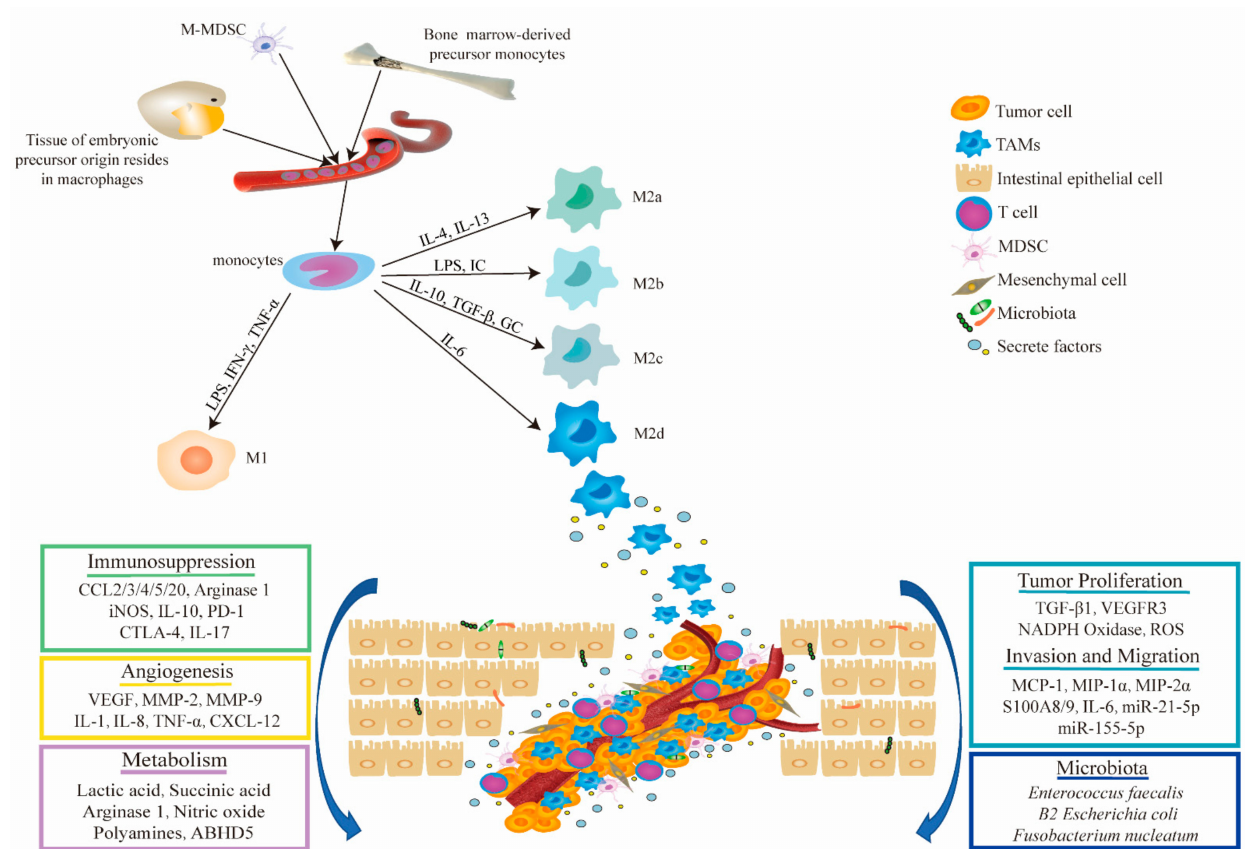
Figure 1. Origin and phenotypic polarization of TAMs and their functional mechanism in CRC. TAMs mainly originate from monocytes which arise from bone marrow-derived precursors, tissues of embryonic precursors, and myeloid-derived suppressor cells (M-MDSC). TAMs can be polarized into classically activated M1 (pro-inflammatory) and alternatively activated M2 (anti-inflammatory) macrophages. TAMs promote tumor occurrence and malignant progression by stimulating tumor-related angiogenesis; promoting tumor cell proliferation, invasion, and metastasis; inhibiting the antitumor immune response; regulating metabolism; and interacting with microbiota in the GI tract. LPS, lipopolysaccharide; IC, immune complex; GC, glucocorticoid. The legend for different cell types is shown in the upper